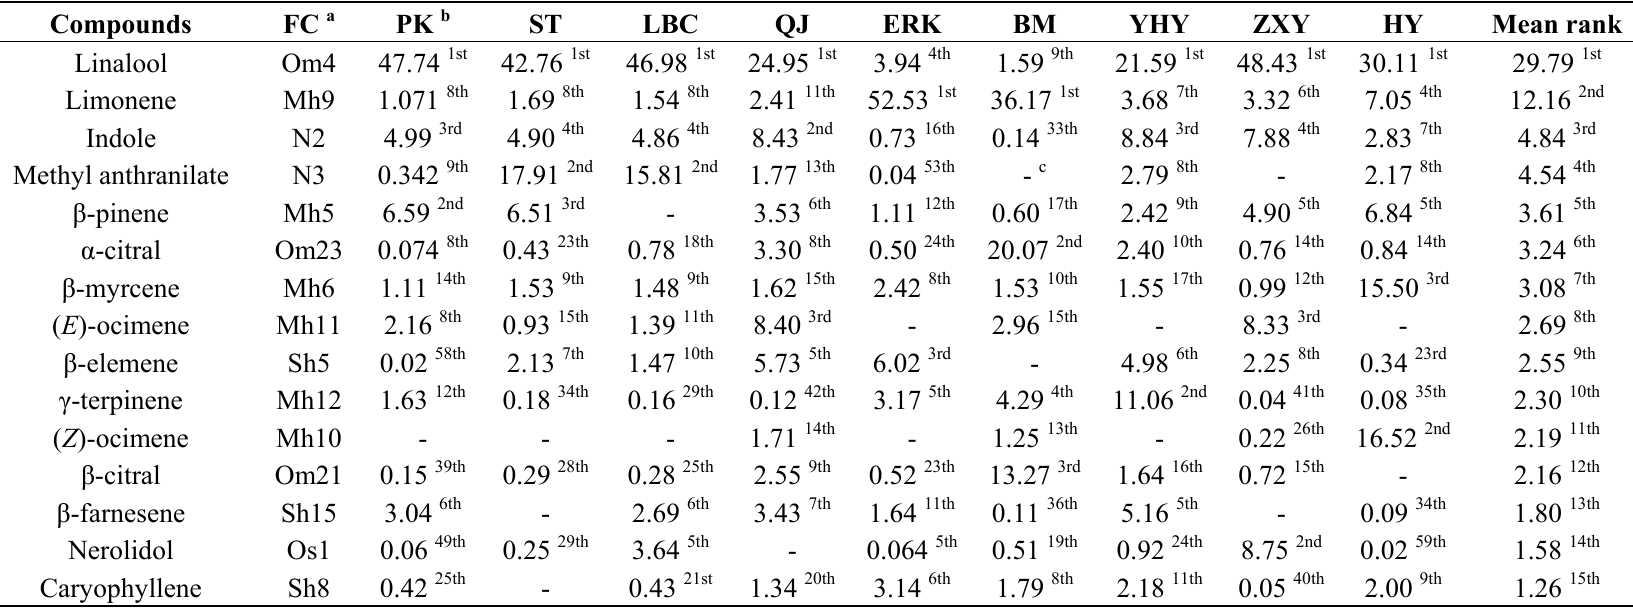
Table 5. Major volatiles compounds, in percentages and rank, from fully opened flowers from nine citrus